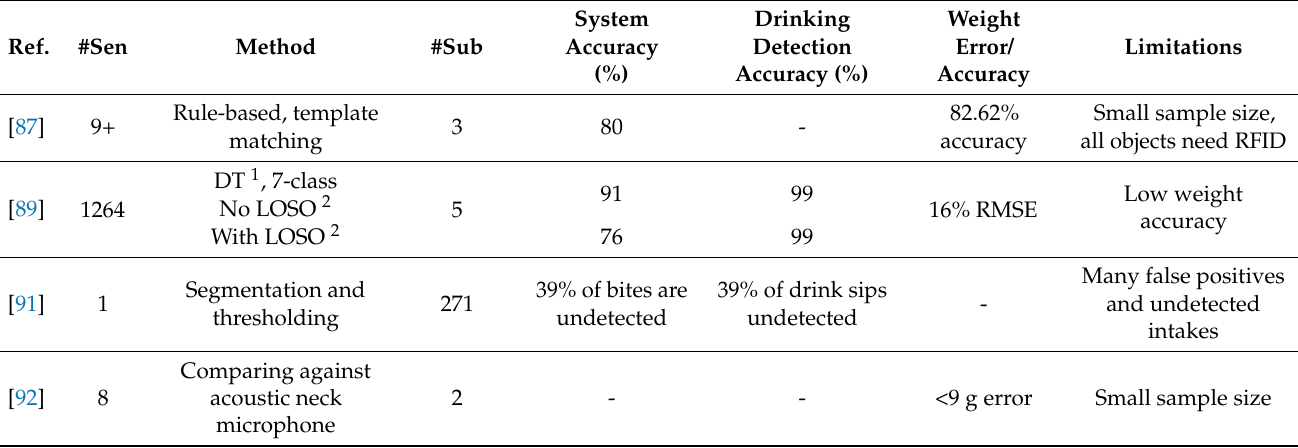
location. Table 2 summarizes the top four studies that used surface technology for fluid intake detection. Table 2. Summary of surface embedded literature. The drinking detection accuracy shows the classification accuracy for detecting drinking action only, while the system accuracy is the average classification accuracy considering all classes. The weight error/accuracy shows the performance for identifying the volume intake.